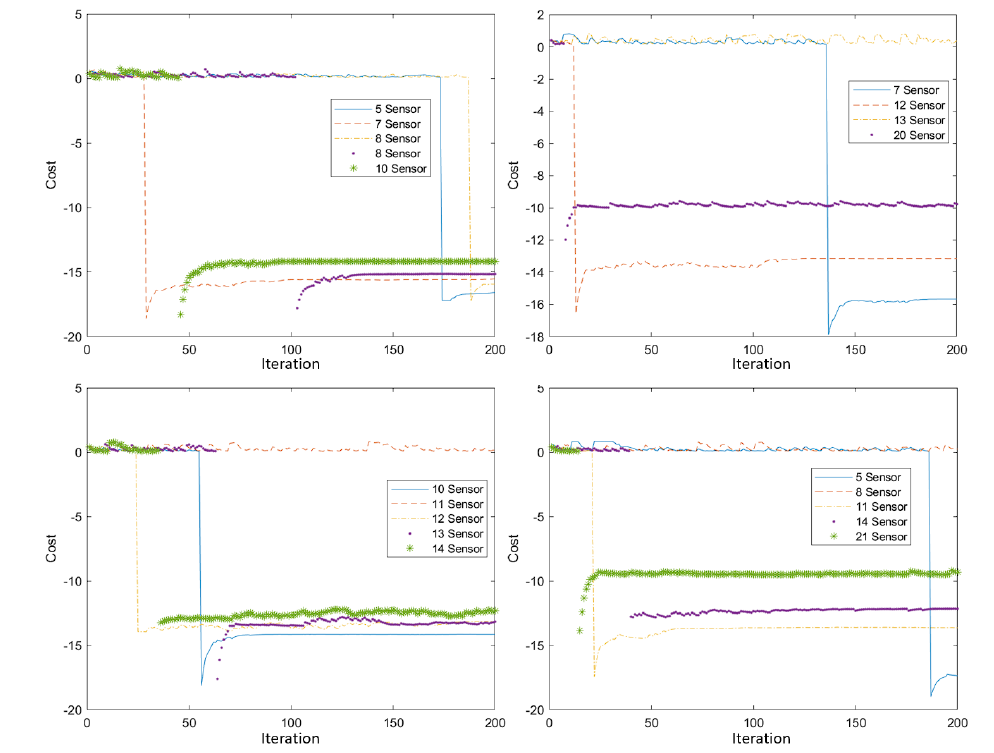
Figure 21. The two-level cost function for different numbers of